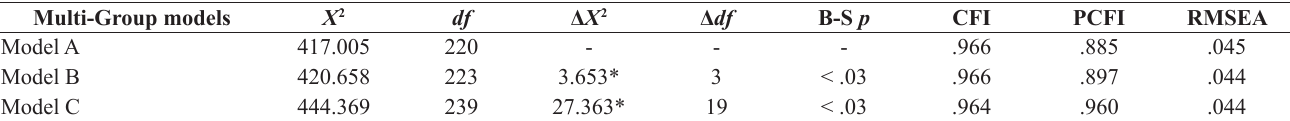
Table 3. Results of the Multi-Group Analysis across the Unconstrained Model and the Constrained Models of the QAD-Fit (Calibration sample: n = 231; Validation sample: n = 222) Multi-Group